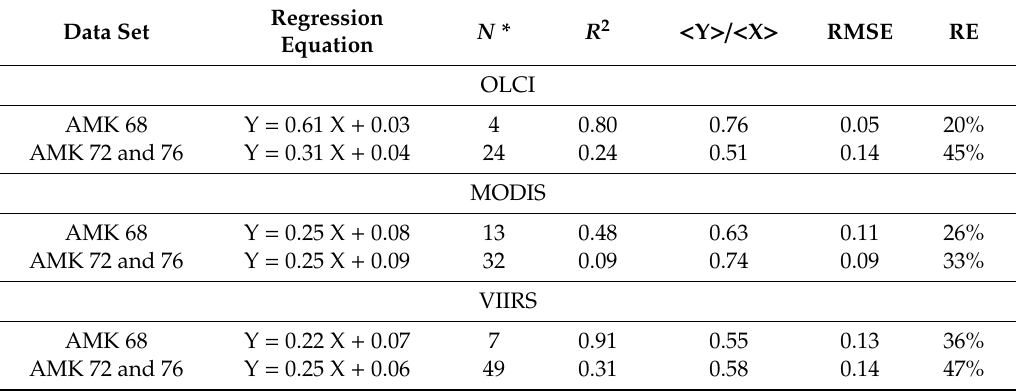
Table 9. Correspondence parameters between the K d (490) values obtained from field measurements (X) and satellite data (Y). Satellite data for the nearest